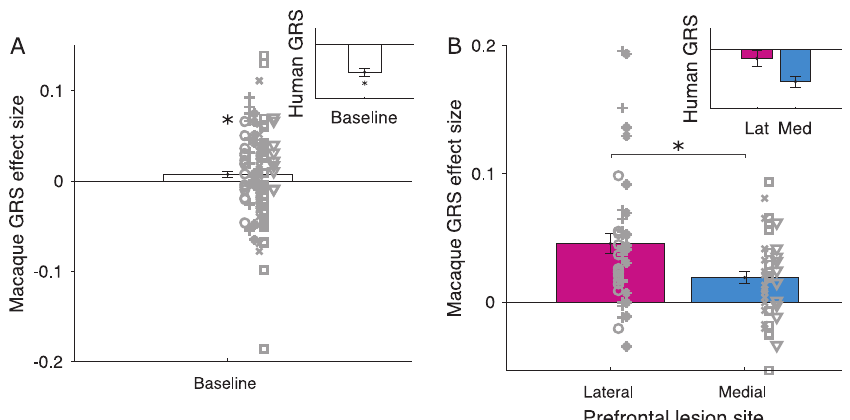
Fig 5. Positive GRS effects in macaques increase after lateral frontal lobe lesions. (A) In intact monkeys, we found a small but significantly positive effects of the GRS on stay decisions, which was sign-reversed relative to the negative GRS effect we had found in humans. The inset shows the human GRS effect averaged for all ages (11–35 years) in the matched experimental paradigm (see Fig 3, study 1). (B) We compared the effects of frontal lobe lesions in the macaque monkey and revealed that the positive GRS effects after lateral frontal lesions were significantly stronger compared to medial lesion groups. The pattern mirrored the human lesion results but in the opposite direction, with lateral lesions in humans abolishing the negative GRS effect (inset: GRS effects from Fig 4, study 3; “Lat” abbreviates “Lateral,” and “Med” abbreviates “Medial”) ( � p < 0.05). Data for A and B are available in S1 Data (Figure 5